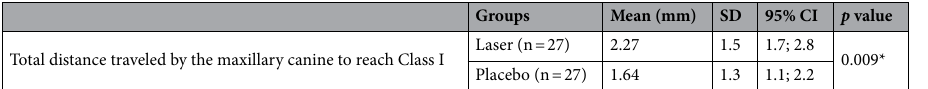
Groups Mean (mm) SD 95% CI p value